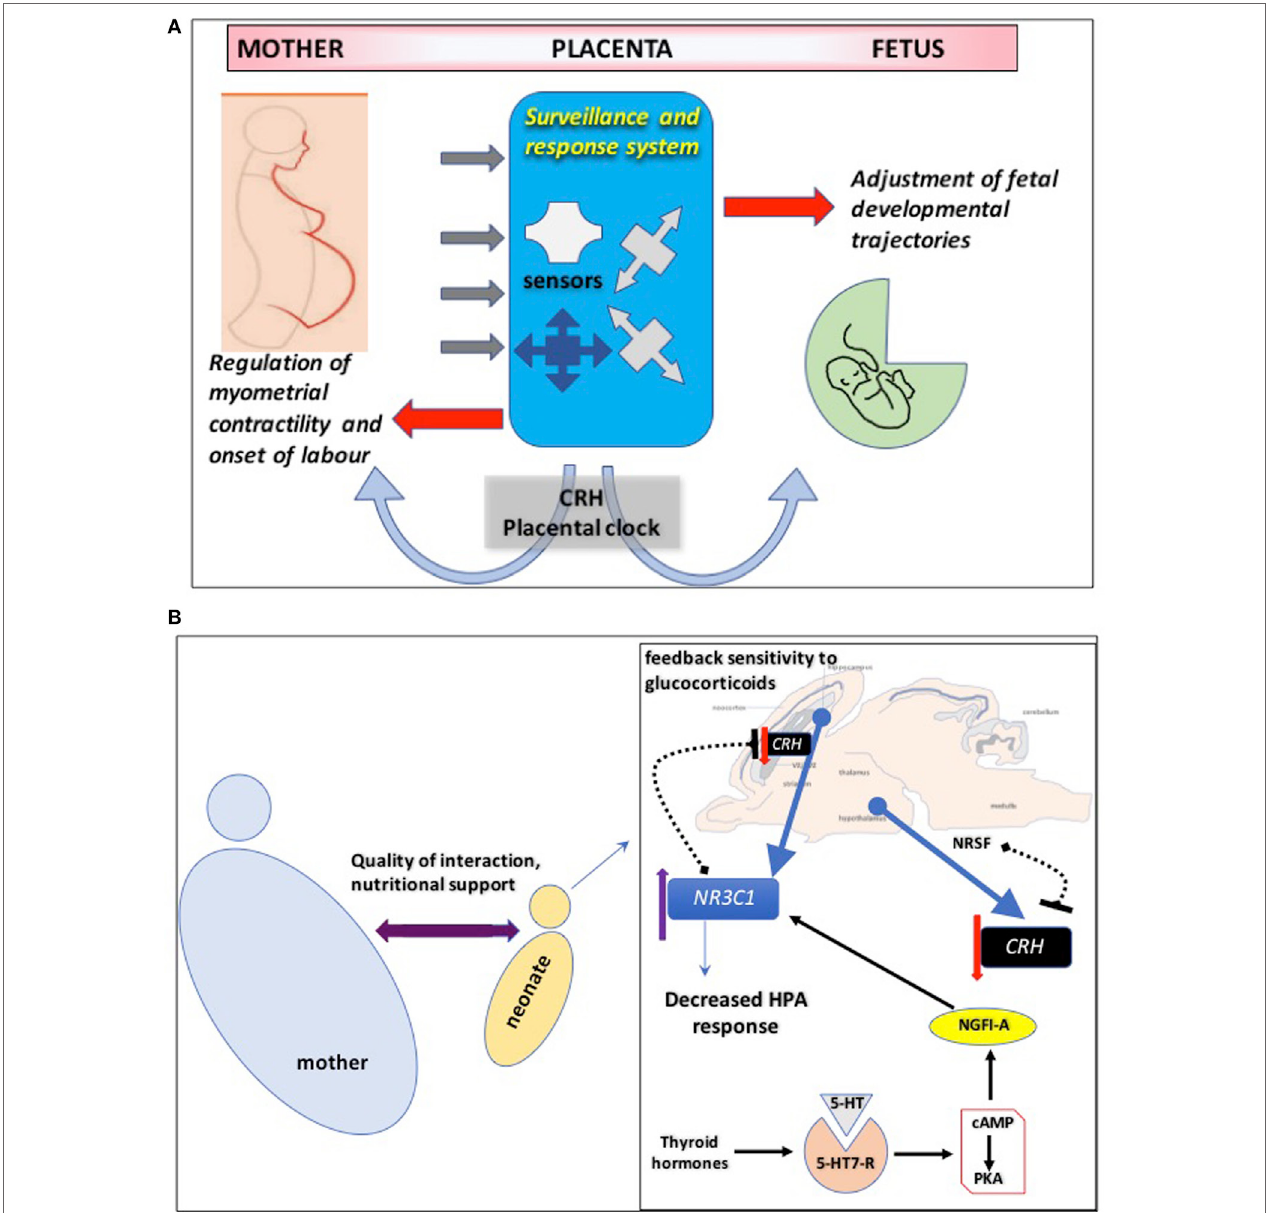
FigURe 2 | (A) Corticotropin-releasing hormone (CRH) controls the placental “surveillance and response” system so that the fetus can detect threats to survival and adjust its developmental trajectory. The placenta employs an intricate network of sensors to decode signals from the maternal environment and prepare the fetus for postnatal survival. Disruption of these sensors might have detrimental effects on fetal neurodevelopment. The “CRH placental clock” might be part of this surveillance and response system: when stress signals such as cortisol from the maternal environment are detected by the fetal/placental unit, the “placental clock” may adapt by altering rate of synthesis of the “master” stress hormone, CRH. The rapid increase in circulating CRH might initiate mechanisms targeting maternal tissues to regulate myometrial contractile machinery and the onset of labor. In parallel, fetal developmental trajectories are adjusted to accelerate maturation of critical organs such as modification of its nervous system to ensure survival in a potentially hostile environment. (B) Maternal behaviors resulting in decreased hypothalamo-pituitary adrenal (HPA) axis response to stress in adulthood are most likely driven by enhanced feedback sensitivity of CRH to glucocorticoids in the hippocampus. This involves epigenetic modifications of NR3C1, the gene encoding glucocorticoid receptors, in the brain increasing its mRNA expression via mechanisms that promote binding of the transcription factor nerve growth factor-inducible factor A (NGFI-A). This interaction involves a thyroid-hormone-dependent increase in serotonin (5-HT) activity at 5-HT7 receptors and the subsequent activation of cyclic adenosine monophosphate (cAMP) and protein kinase A (PKA) pathway. Hippocampal CRH gene expression is also regulated by maternal care and early life stress through similar epigenetic mechanisms. Similarly, increased histone H3 acetylation and decreased cytosine methylation in the promoter region of CRH gene in hippocampal CA1 layer promote mRNA expression of the neuropeptide. One potential mechanism that enables positive environmental signals (induced by augmented maternal care) to influence transcription of the CRH gene in the offspring hypothalamus involves increased hypothalamic levels of the repressor neuron-restrictive silencer factor (NRSF). NRSF represses the transcription of the CRH gene by binding in the regulatory region of the CRH gene, an epigenetic regulation that persists into adulthood.